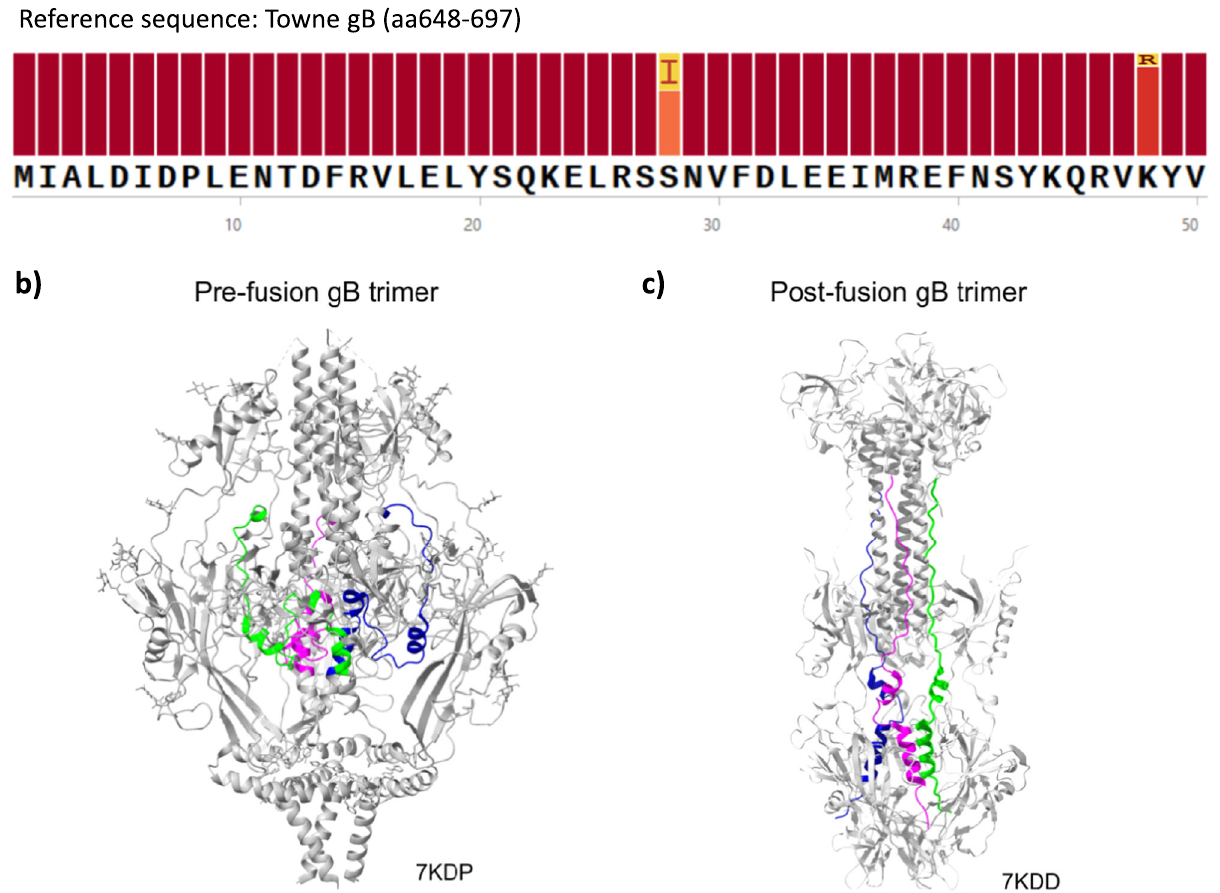
Fig. 2 | AD-6 sequence conservation and location in gB trimer. a A multiple sequence alignment of gB sequences from Genbank was assembled using MAFFT online server. Sequences from synthetic strains were removed. The Towne strain